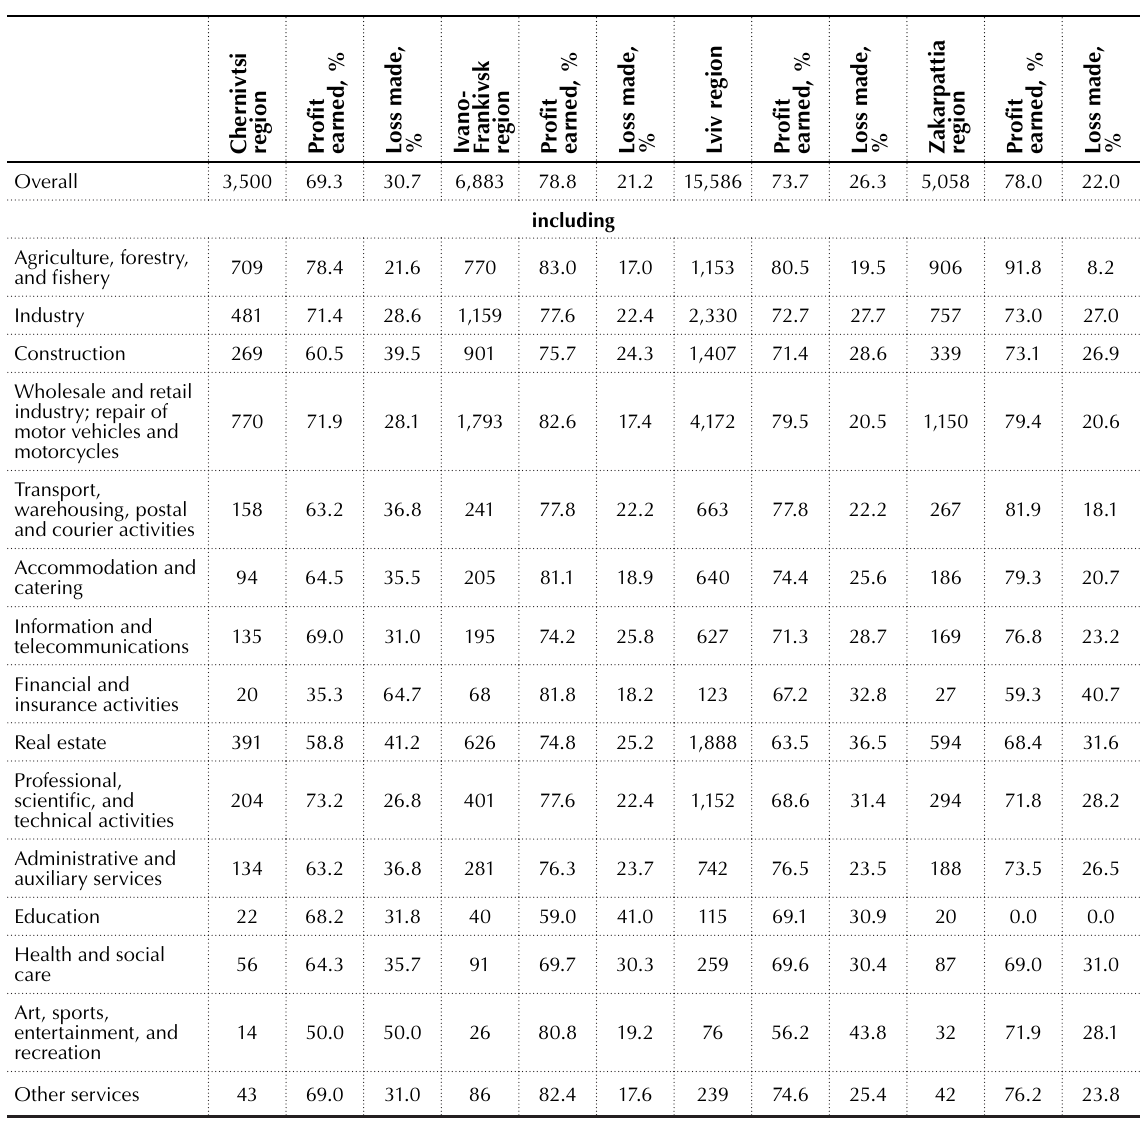
Table 3. Growth areas of the Carpathian economic region determined from the number of profitable industries for 2016 Source: developed by author on the basis of review of the information